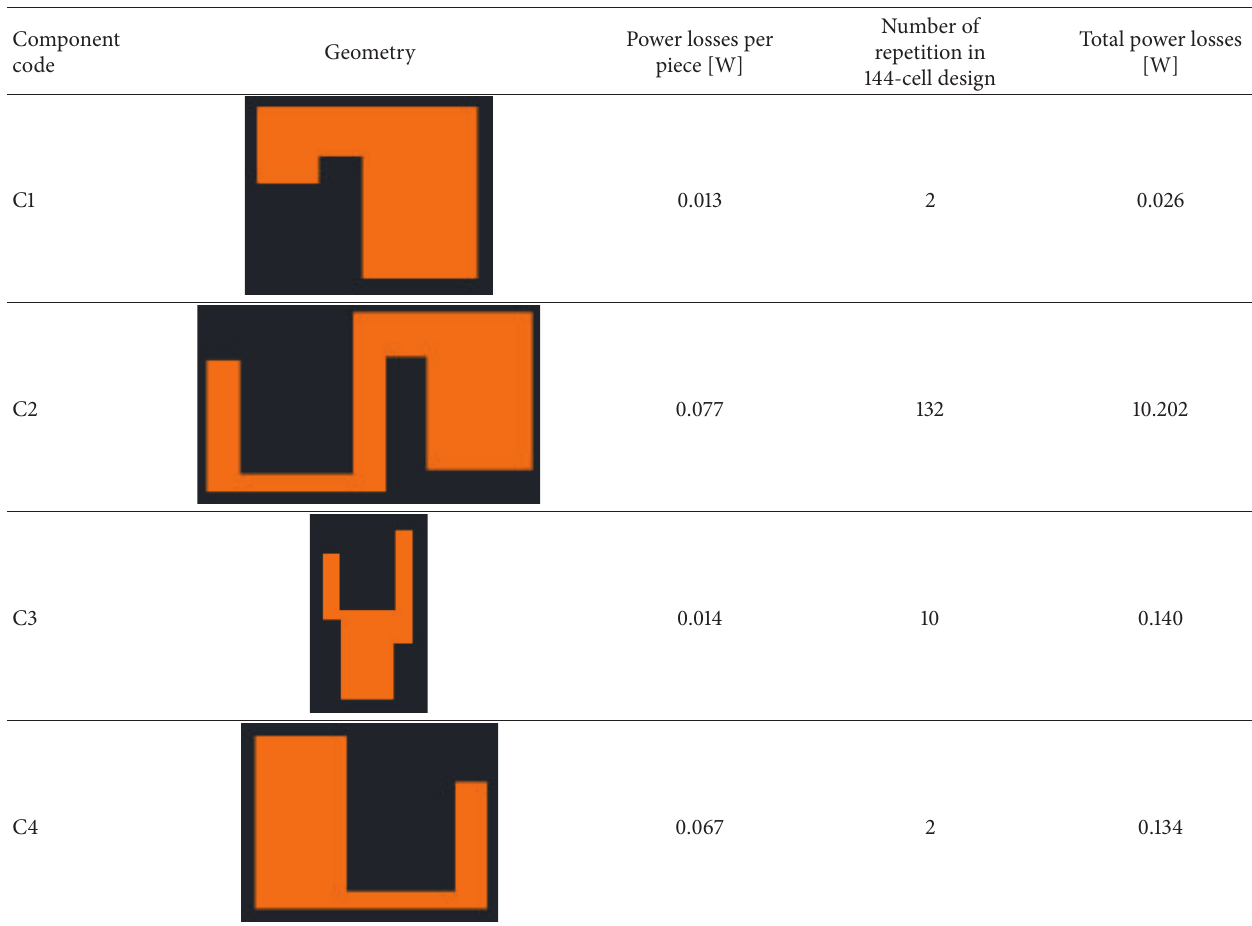
Table 7: Power losses breakdown in the conductive